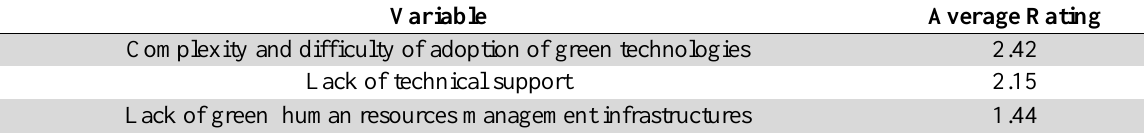
Results of Friedman test for technological factors